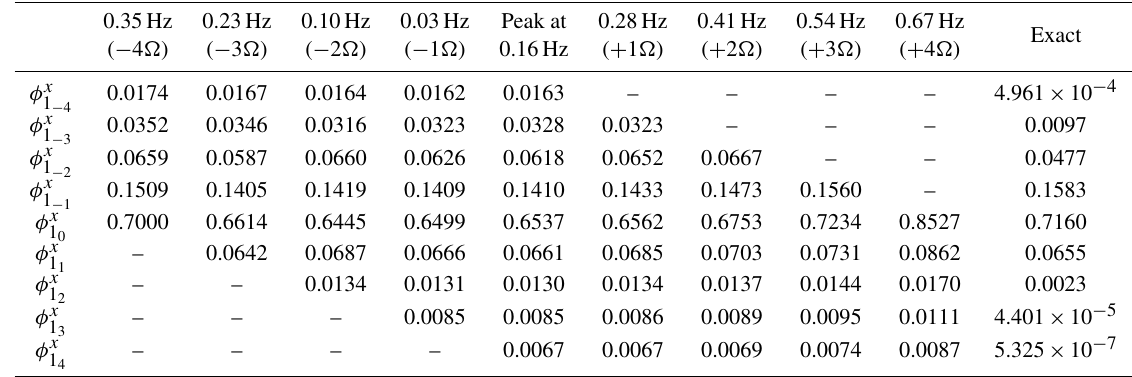
Table 2. Most relevant output-specific participation factors for the Mathieu oscillator and related analytical results. 0.35Hz 0.23Hz 0.10Hz 0.03Hz Peak at